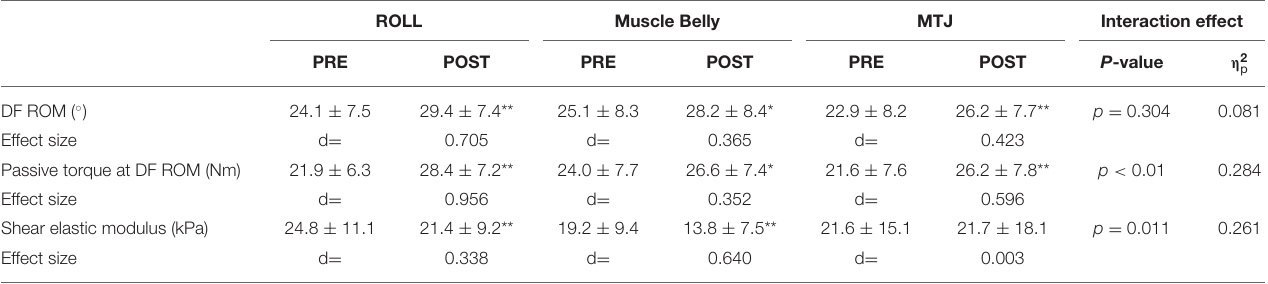
TABLE 1 | Changes in dorsiflexion range of motion (DF ROM), passive torque at DF ROM, and shear elastic modulus before (PRE) and immediately after vibration rolling (ROLL) or vibration on the muscle belly (Muscle Belly) or vibration on muscle-tendon junction (MTJ) intervention (POST). ROLL Muscle Belly MTJ